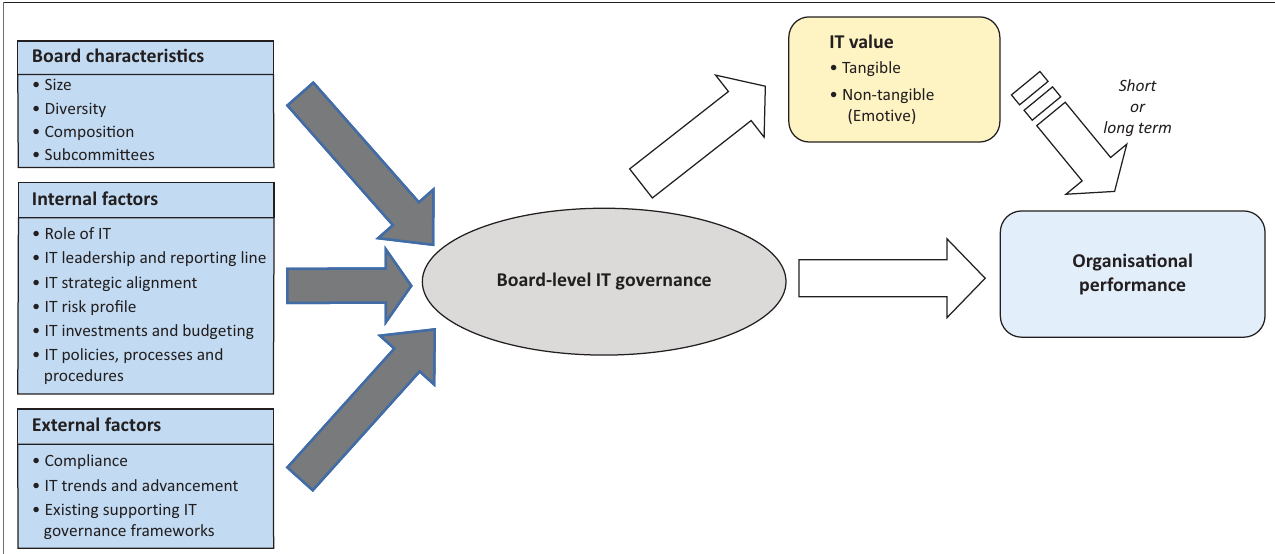
FIGURE 4: Ako-Nai’s board-level information technology governance